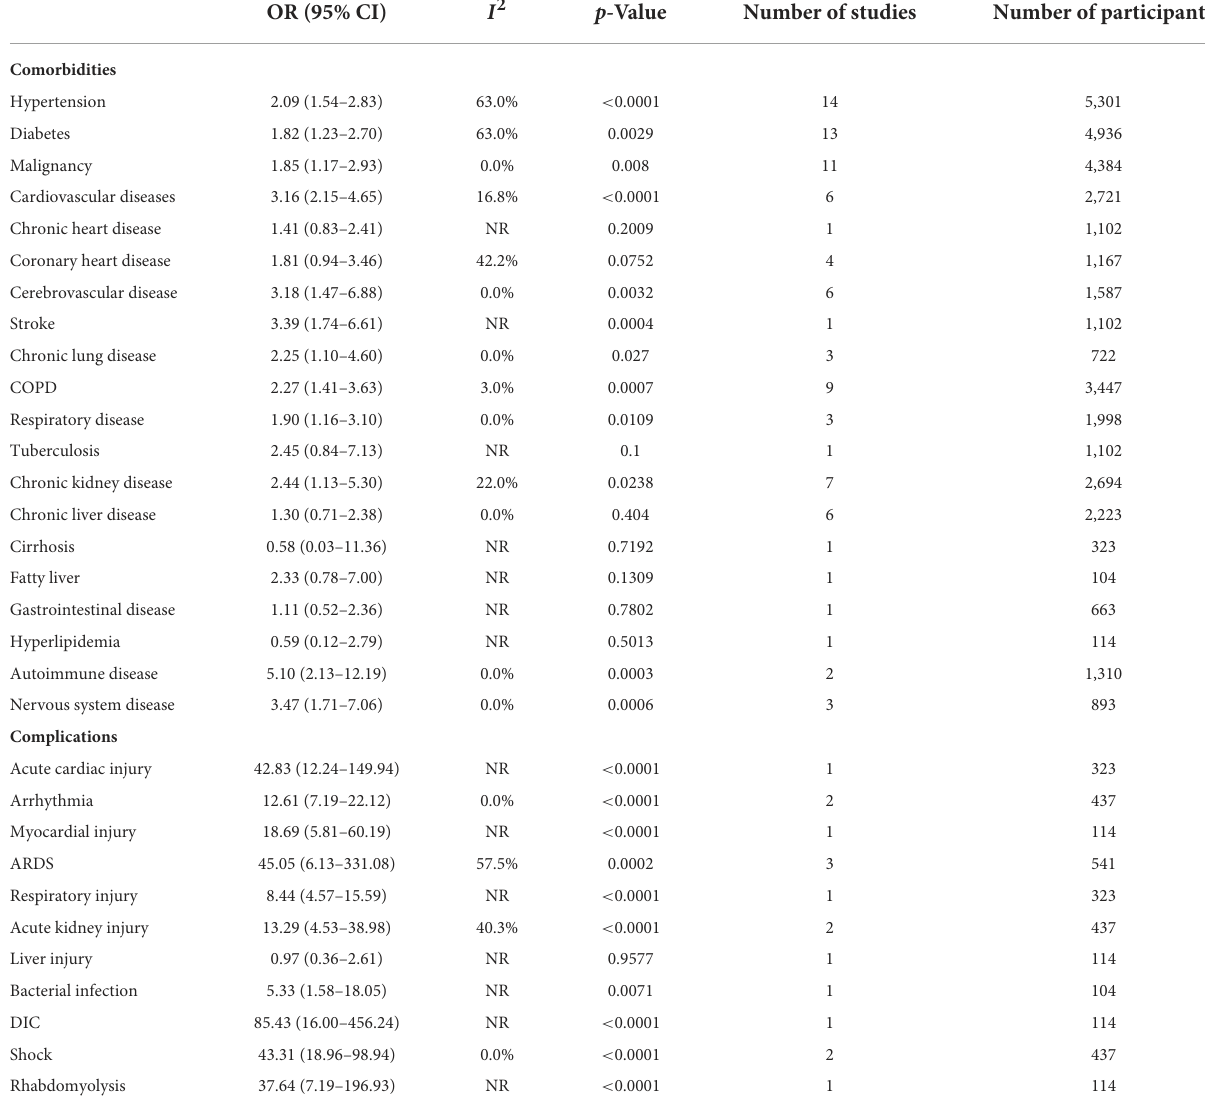
TABLE 3 Meta-analysis summary of comorbidities and complications for COVID-19 by progressive vs. non-progressive. OR (95% CI) I 2 p -Value Number of